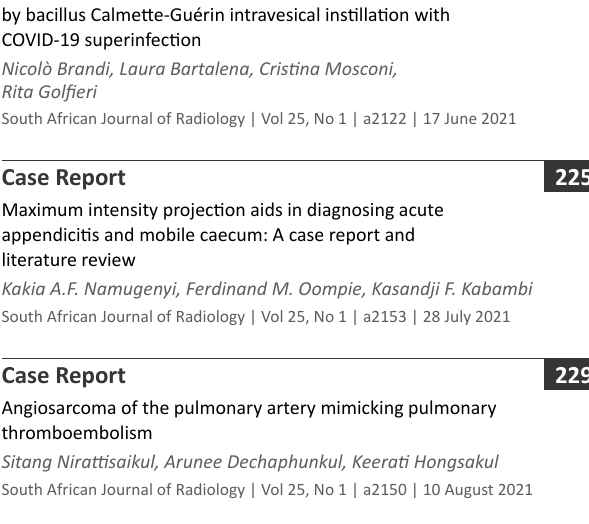
Chemical shift imaging: An indispensable tool in diagnosing musculoskeletal